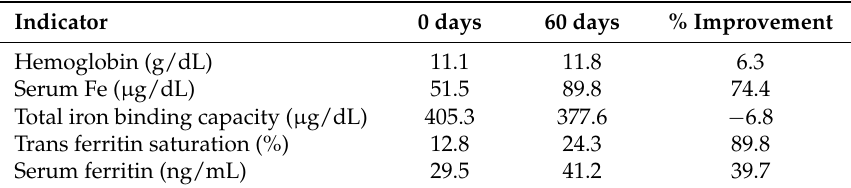
Table 2. Percent improvement of mild anemic children ( n = 33) in Sri Lanka after 60 days of red lentil feeding trial